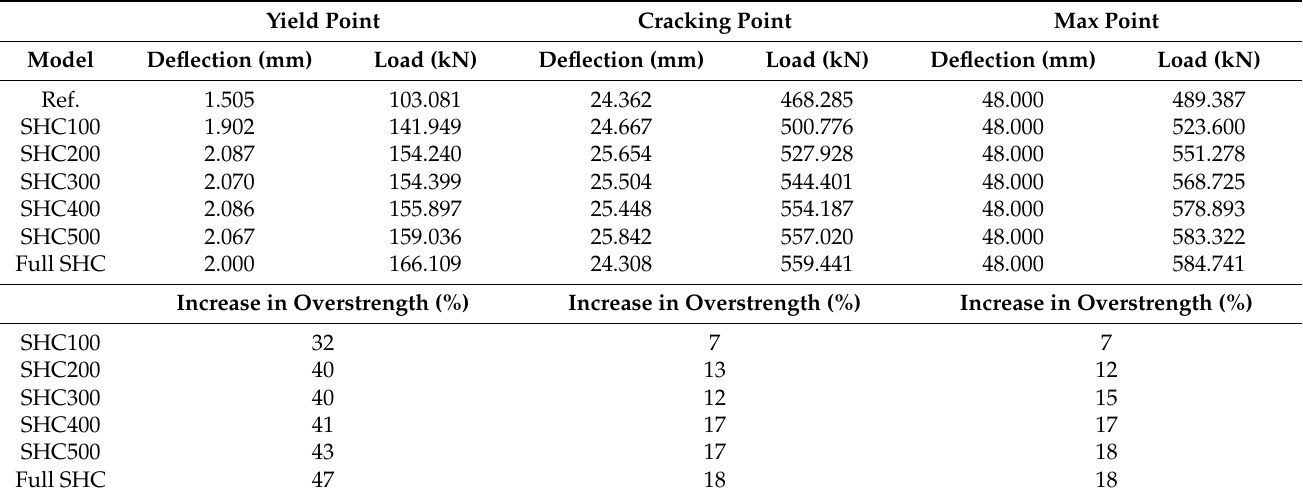
Table 5. Beam model deflection and load results at three critical points, and the increase in percentage with respect to the reference